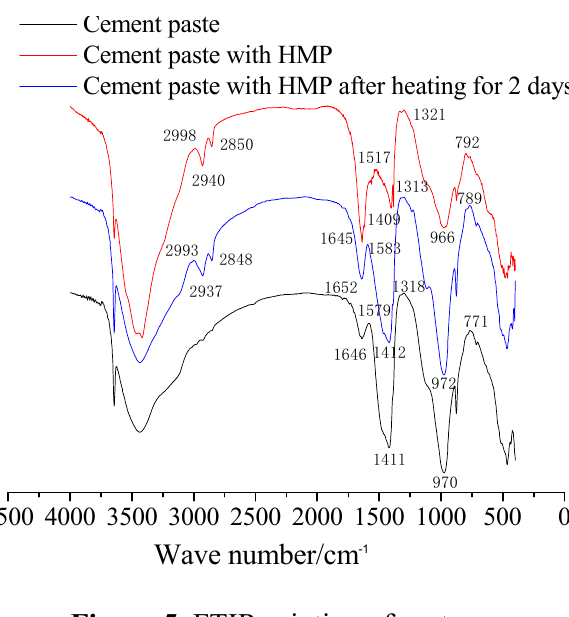
Figure 5. FTIR printing of pastes.